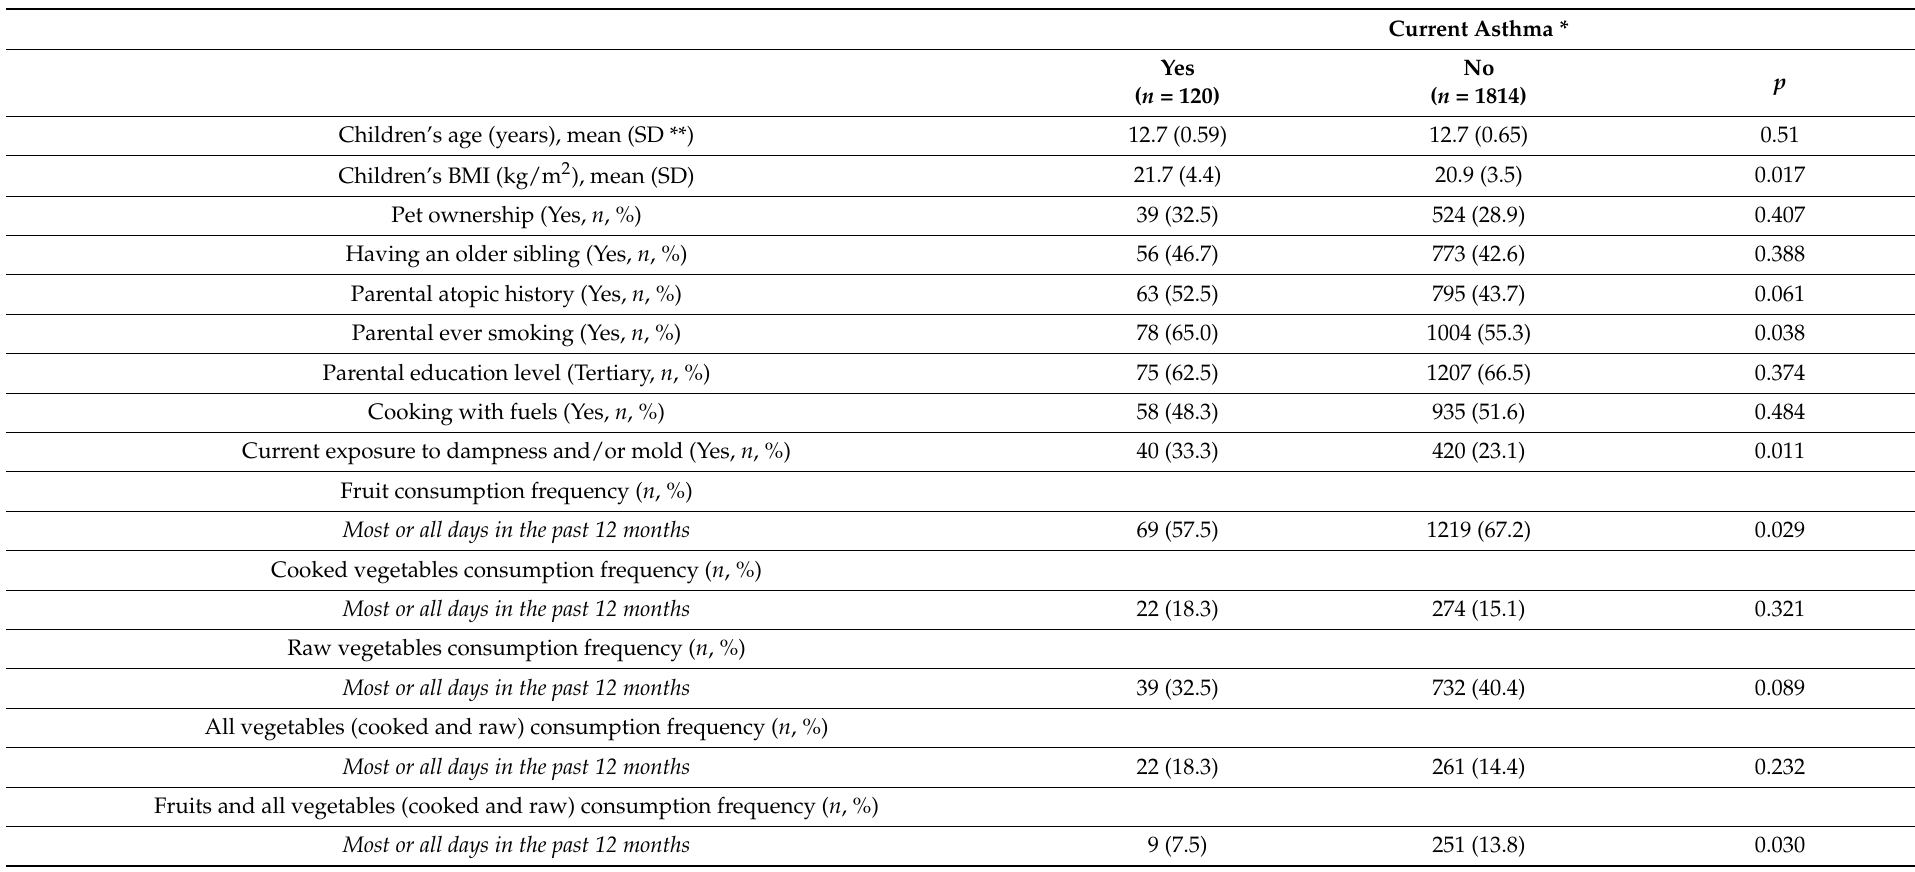
Table 1. Demographic, anthropometric, parental and home environment characteristics and fruit, and cooked and raw vegetable consumption frequency of the participating adolescents according to adolescents’ current asthma status ( n =